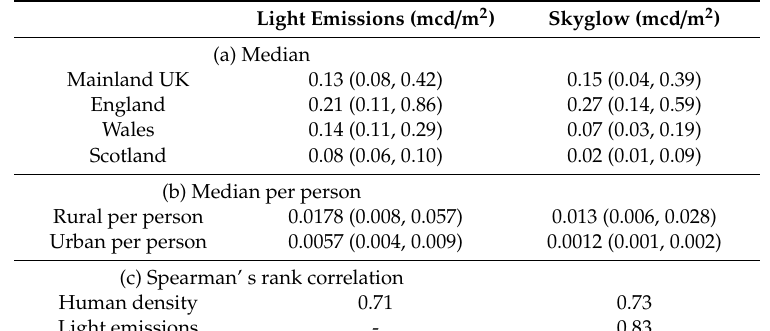
Table 1. Median light emissions and skyglow, ( a ) on mainland Britain and its constituent countries, and ( b ) per person in rural and urban areas. ( c ) The Spearman’s rank correlations between light emissions, skyglow and human density. The interquartile range is given in parentheses (lower quartile, upper quartile).